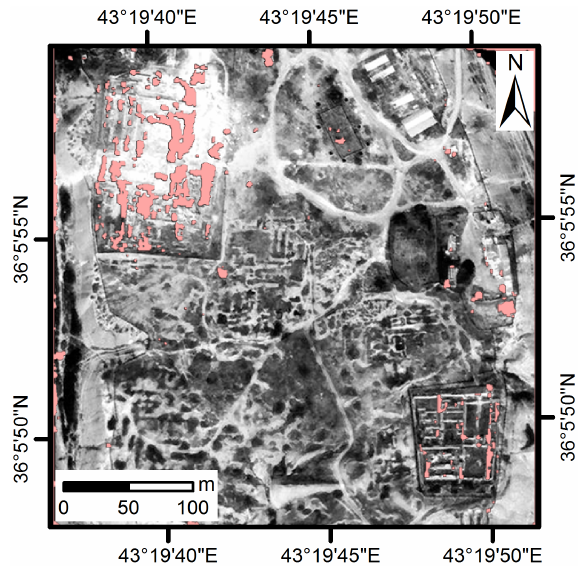
Figure 15. Nimrud change map, overlaid on the post-destruction image (WorldView-2, 20 April